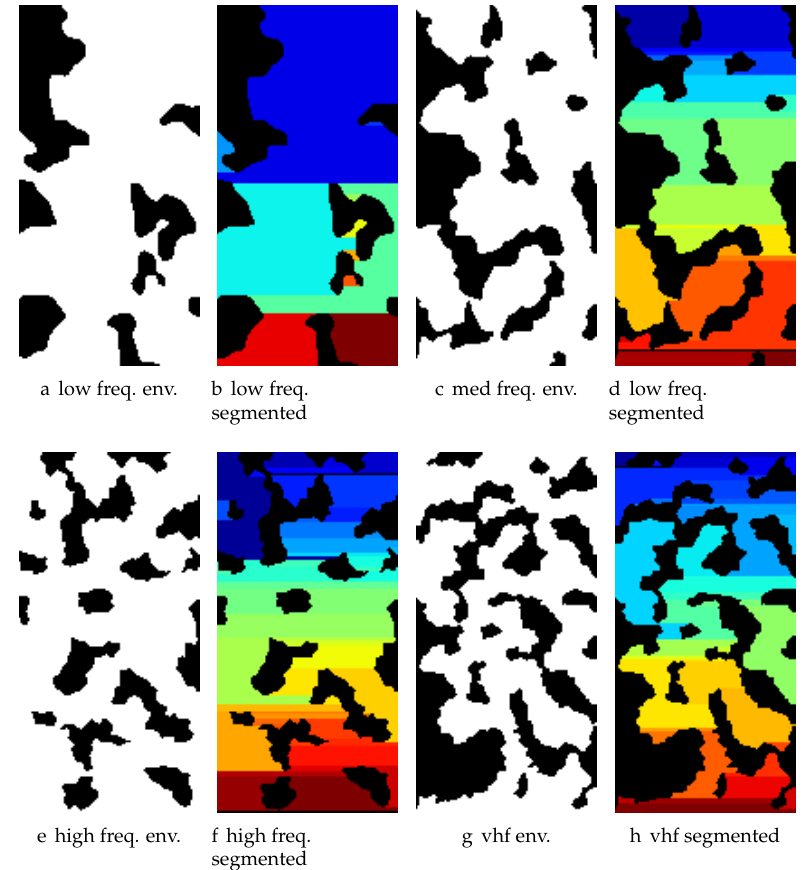
Figure 6. Example environments generated at various frequencies. Black denotes obstacles, and white denotes free space. The white space is divided up into plowable regions by the Boustrophedon algorithm. Each color corresponds to a